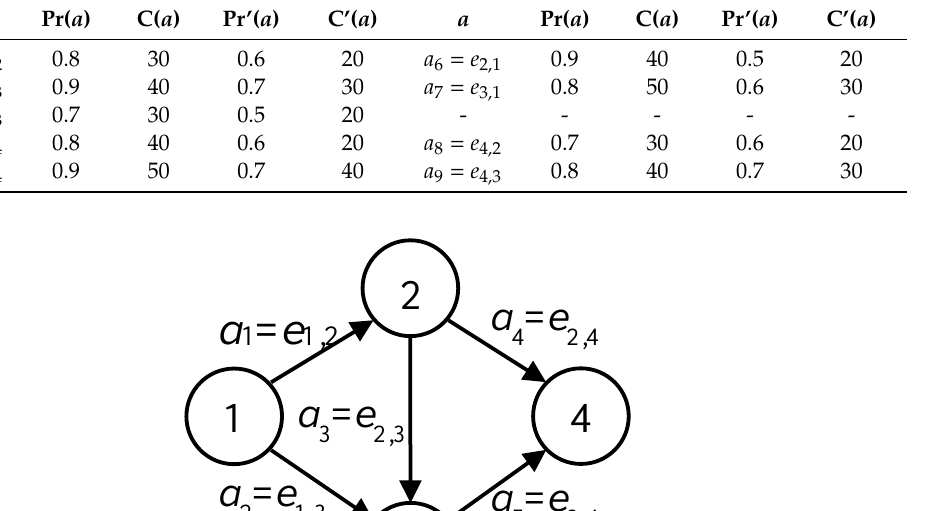
Figure 1. Example network [18]. Table 1. Arc success probability and recovery cost in Figure 1.